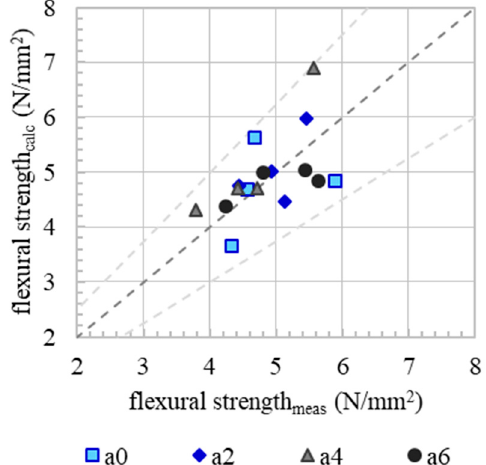
Figure 14. Correlation (dark grey dashed line) of measured and calculated flexural strength. Calculations are based on a modification of Walraven’s model for stress transmission in cracks. Bright grey dashed line indicates the range of certitude (0.75× and 1.25×).